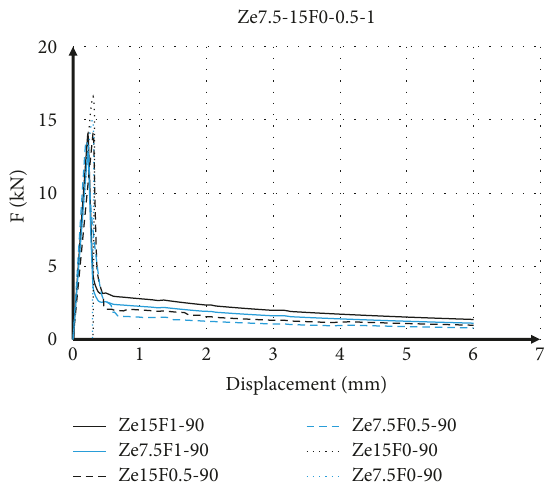
Figure 12: Effect of MPW fiber on flexural behavior of concrete containing zeolite at 90 days.